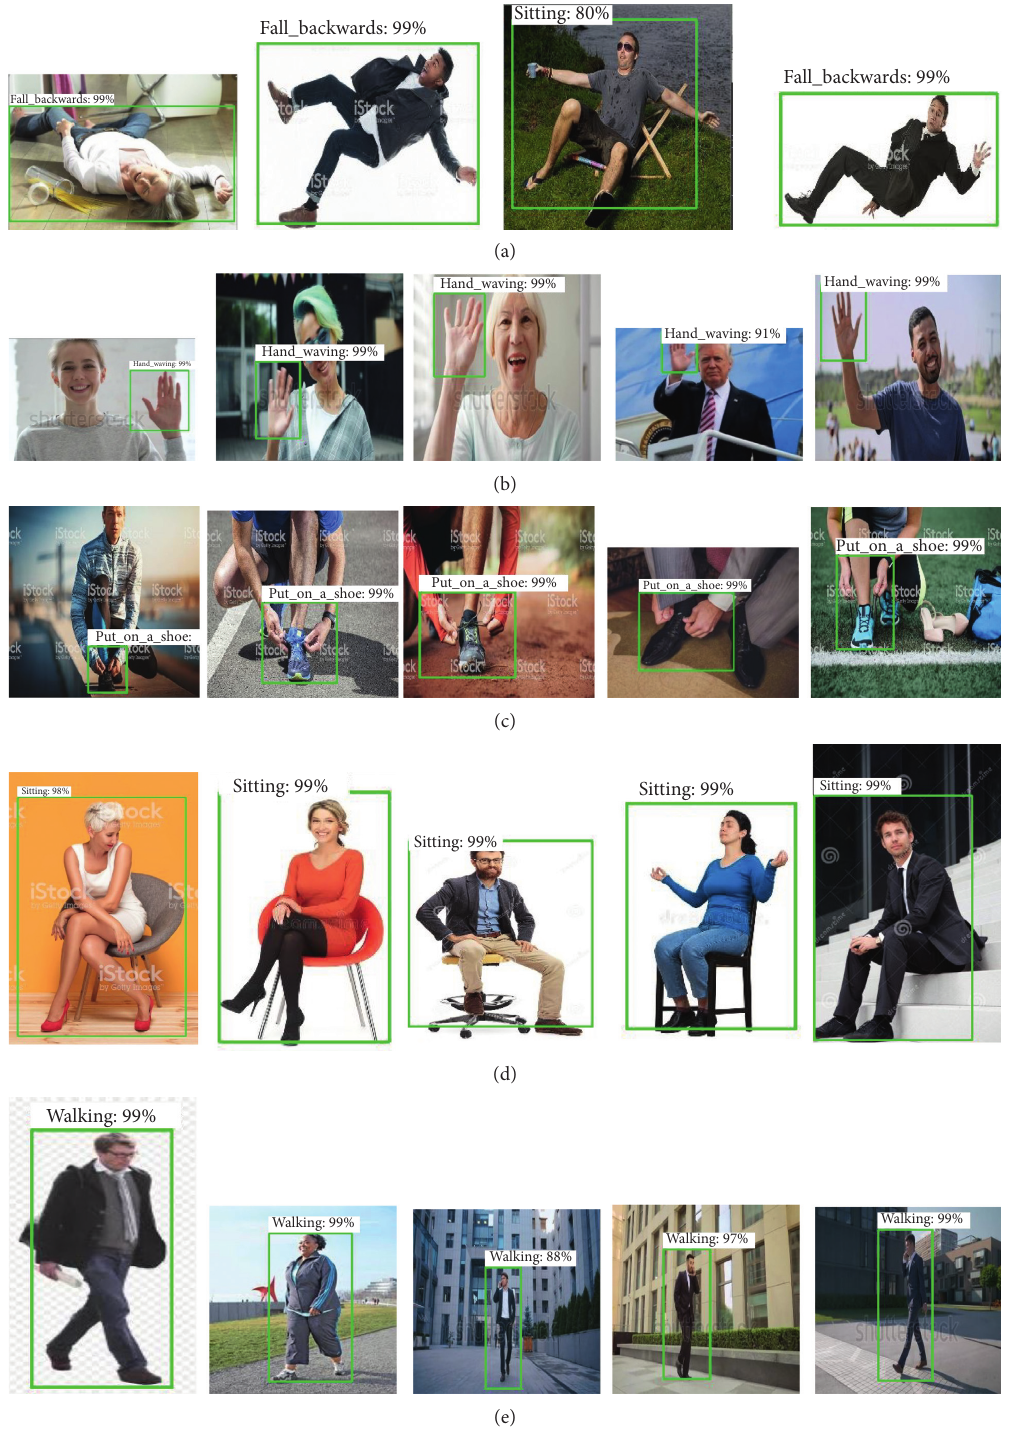
Figure 17: Training results with Tensorflow Lite for (a) falling back, (b) waving hands, (c) wearing shoes, (d) sitting down, and (e)